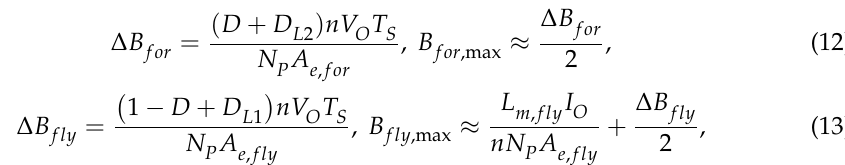
Figure 8. Layout of integrated planar transformer: ( a ) Top layer. ( b ) Second layer. ( c ) Third layer. ( d ) Bottom layer.